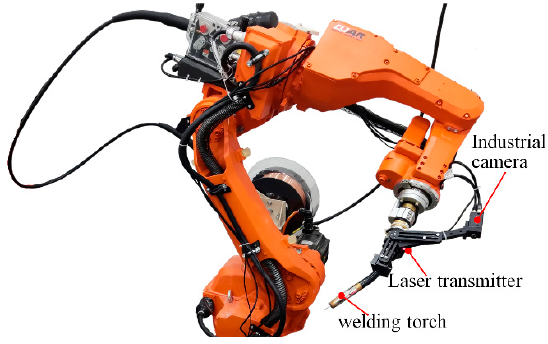
Figure 13. QJRH4-1A welding robot.